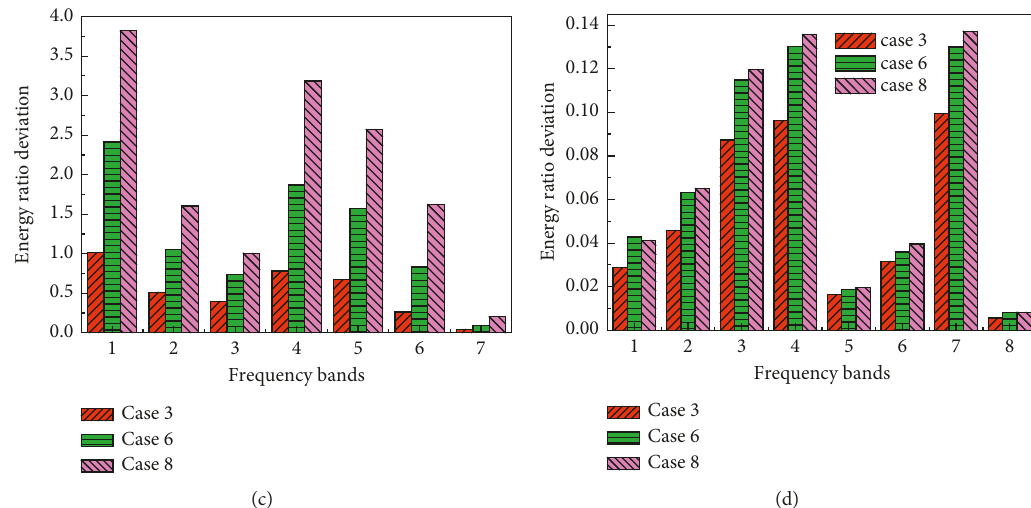
Figure 15: Hilbert damage feature vector spectrum in model tests (two damages). (a) Point 1. (b) Point 12. (c) Point 14. (d) Point 25.